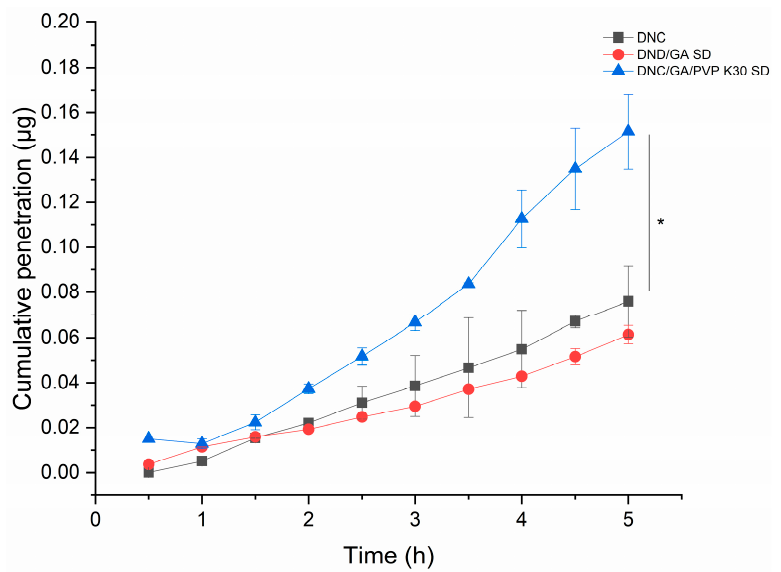
Figure 11. The cumulative penetration of DNC, DNC/GA SD, and DNC/GA/PVP K30 SD versus DNC, * p < 0.05.